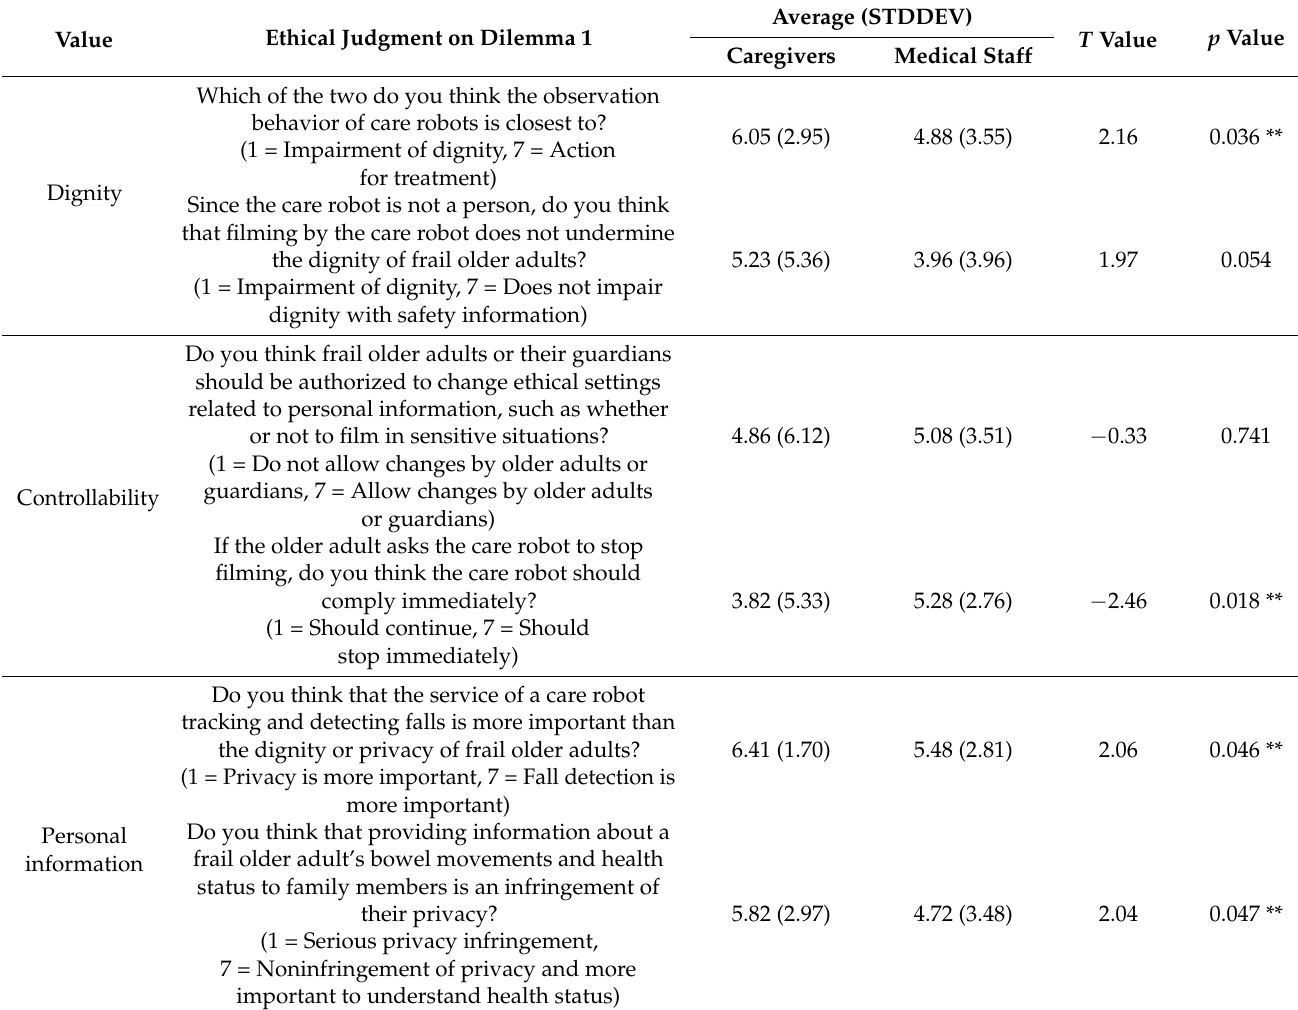
Table 2. Ethical judgment survey results of caregivers and medical staff on Dilemma